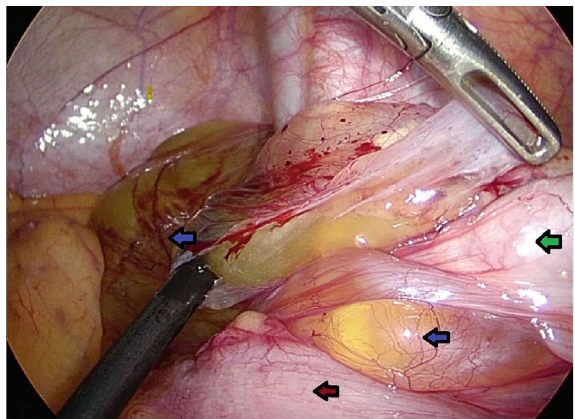
Figure 2: Operative photograph of laparoscopic exploration showing cecum (green arrow) gelatinous material (blue arrows) and terminal ileum (red